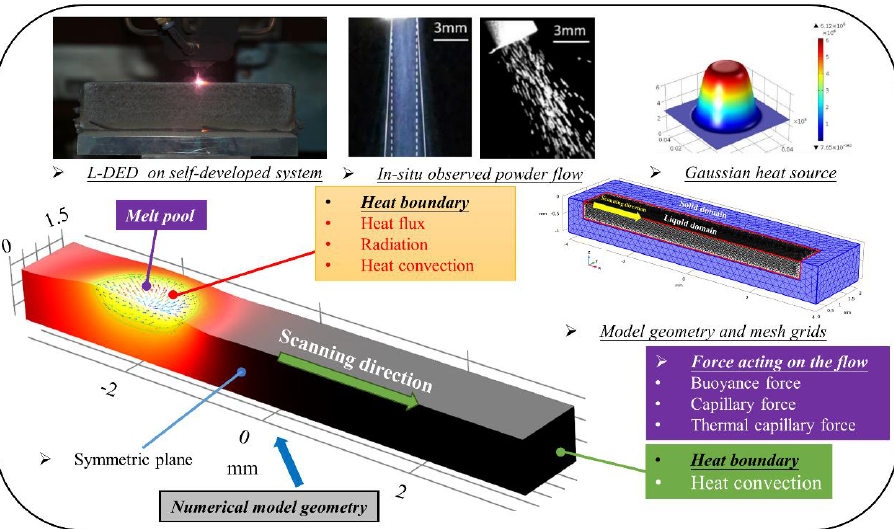
Figure 1. Schematic diagram for the L − DED of Co − based powders to 38MnVS. Model geometry, mesh discretization, laser heat source, and experimental observation. Parameters: Laser power of 700 W, laser scanning speed of 10 mm/s, laser spot radius 1.0 mm, mass flow radius 2.5 mm,